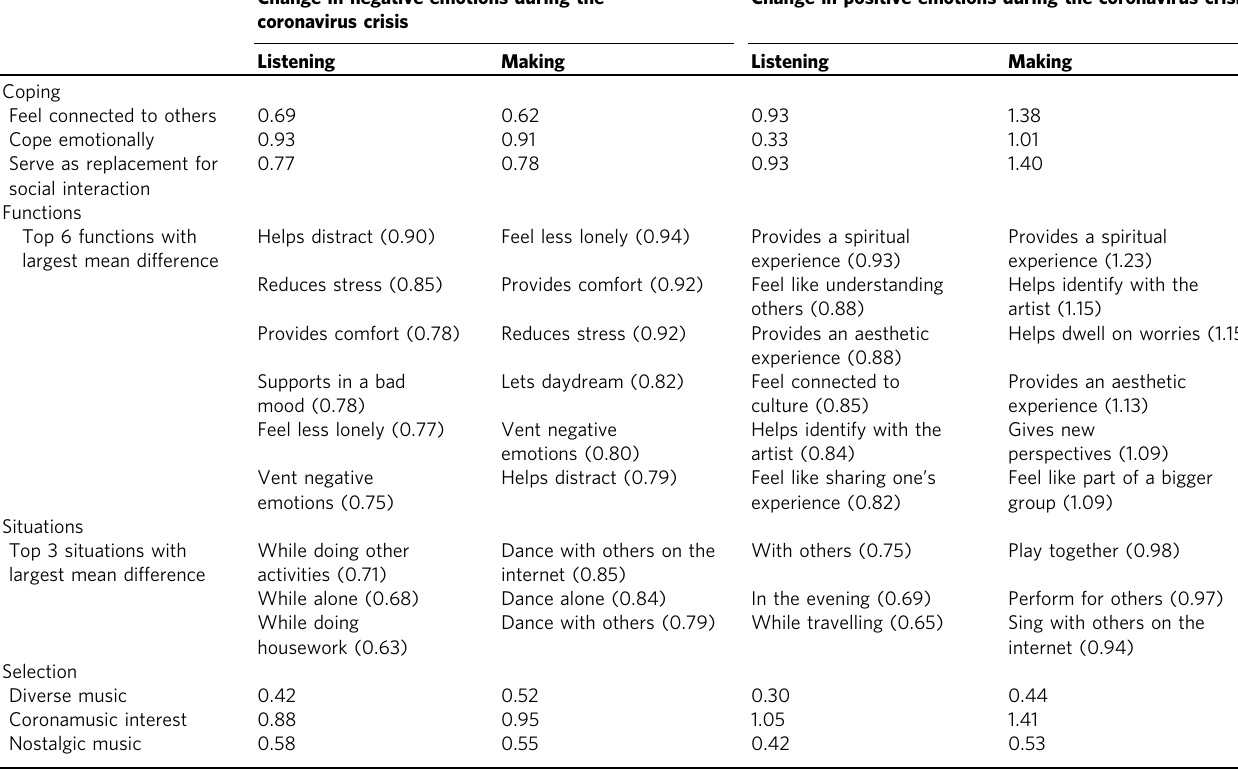
Table 1 Overview of individual differences in music-related coping, functions, situations, and selection for two latent variables that describe changes in positive and negative emotion during the coronavirus